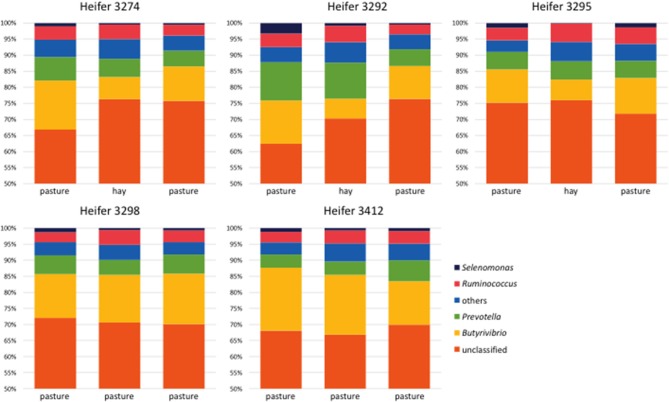
Relative abundance of bacterial genera observed in all heifers during all sampling periods and representing on average ≥1% of the total 454 pyrosequencing reads recovered from each animal. OTUs were classified to the genus level using the Greengenes database (DeSantis et al., 2006) with a consensus confidence threshold of 80 percent. OTUs from the liquid and solid phases from each heifer for each period were pooled to simplify the comparison. OTUs classified as genera that were not present in all five heifers during each sampling period and that were on average ≤1% relative abundance were condensed and are represented as “others.” Subsampling was performed to normalize among the samples. Regardless of heifer, or diet, most OTUs were unclassifiable at the genus level. The most dominant classifiable genera observed were Butyrivibrio, Prevotella, and Ruminococcus.